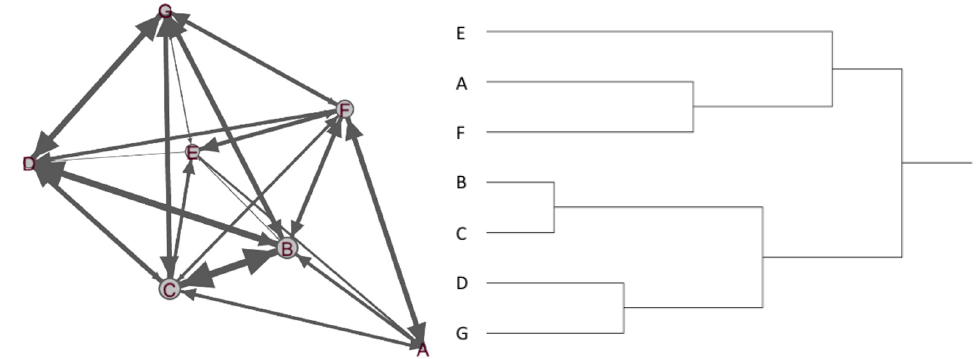
Figure 6. A sociogram (left) and hierarchical clustering (right) for the Colourful Youth program.